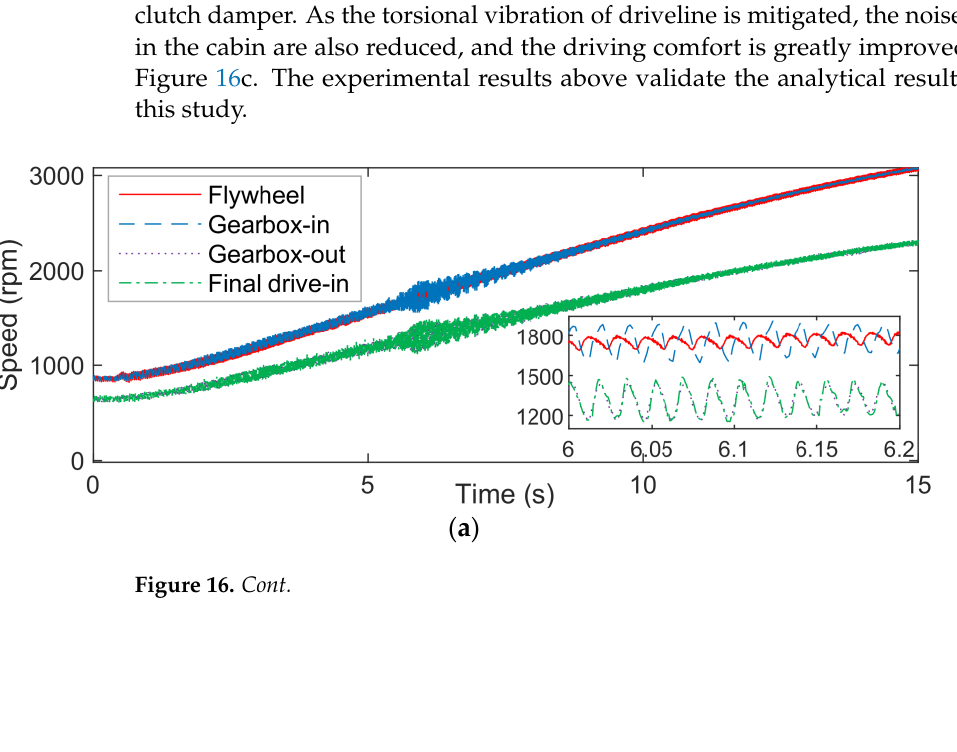
( c ) Figure 16. Measured results of the optimized clutch. ( a ) Speeds of the revised clutch; ( b ) the sec- ond − order speed fluctuation of transmission; ( c ) noise and vibration in the cabin. 7. Conclusions (1)